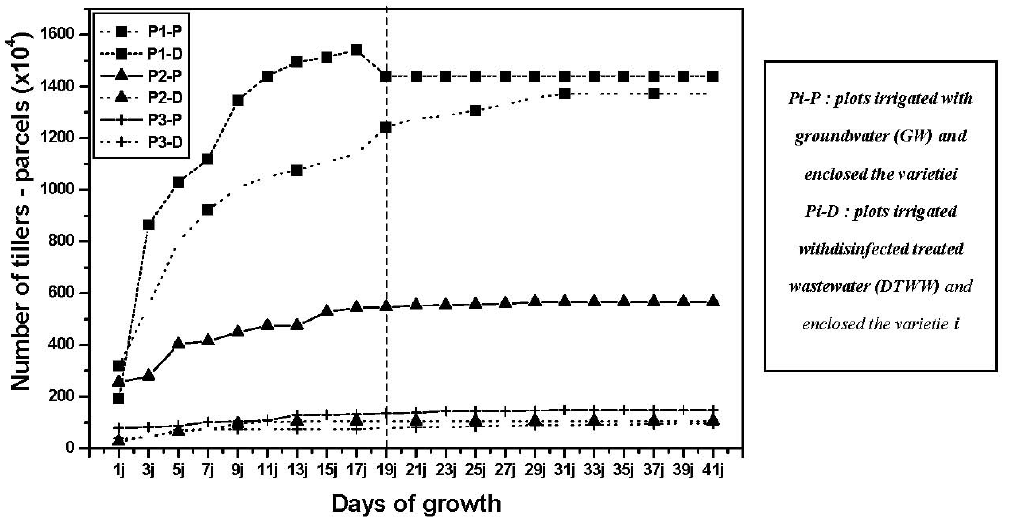
Figure 4. Evolution of the number of tillers in the irrigated plots with the two qualities of water: groundwater and disinfected treated